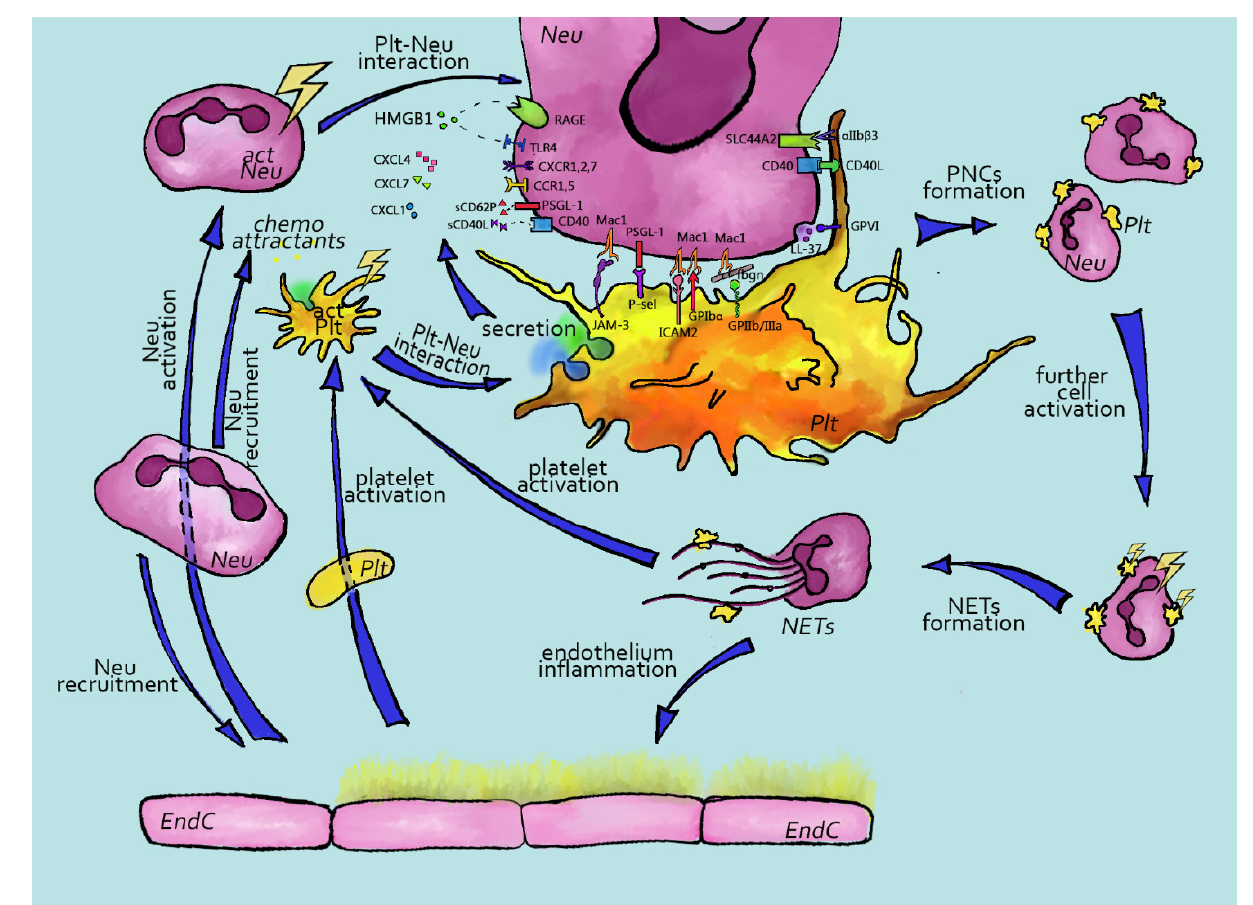
Figure 1. Mechanisms of platelet–neutrophil complex formation. Upon endothelial cell disruption, platelets and neutrophils become activated due to exposure to collagen and activated endothelial cells. Platelet activation results in P-selectin exposure and subsequent neutrophil activation via P- selectin–PSGL1 interaction. Neutrophil activation is further enhanced upon platelet granule content release (CXCL4, CXCL7, CXCL1, HMGB1). The synergistic activation of neutrophils by all these agents via Mac-1, PSGL-1, SLC44A2 and CD40 receptors eventually results in platelet–neutrophil complexes and neutrophil DNA-trap secretion—NETosis. NETs contain the proteases cathepsin G, neutrophil elastase and myeloperoxidase, which can both activate platelets and the coagulation cascade. Multiple positive feedback loops are present at all levels of this system and, thus, both platelet and neutrophils become involved in immunothrombosis and subsequent thromboinflammation. Cell activation is shown by yellow lightnings. Dotted lines represent interactions of soluble mediators and receptors. NET—neutrophil extracellular trap, PNC—platelet–neutrophil complex, Plt—platelet, Neu—neutrophil.